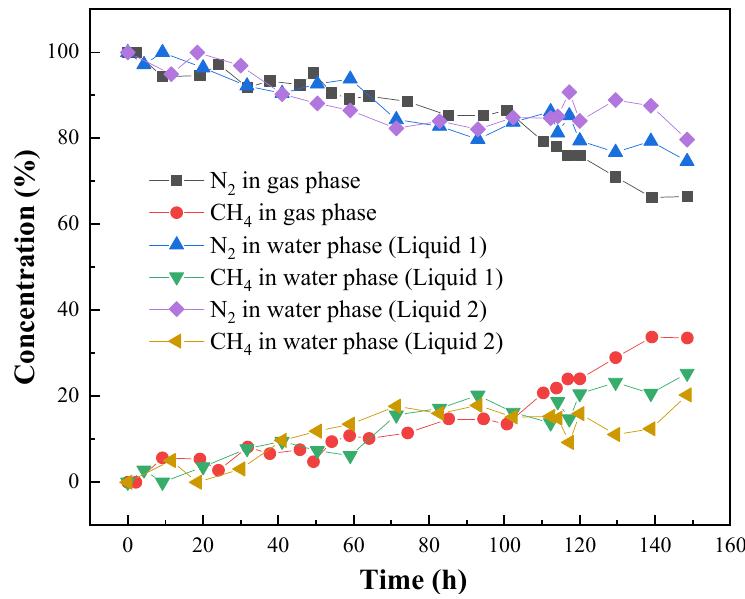
Figure 14. Changes of CH 4 and N 2 proportions of dissolved gas in the liquid phase and free gas in the gas phase during the whole experiment.